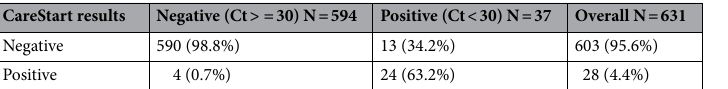
Table 5. CareStart test results compared to RT-qPCR using Ct positivity threshold of < 30.